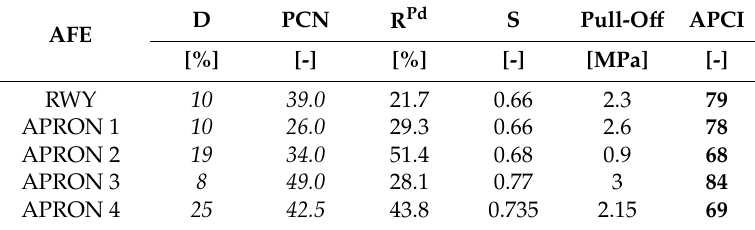
Table 1. Test results of in situ